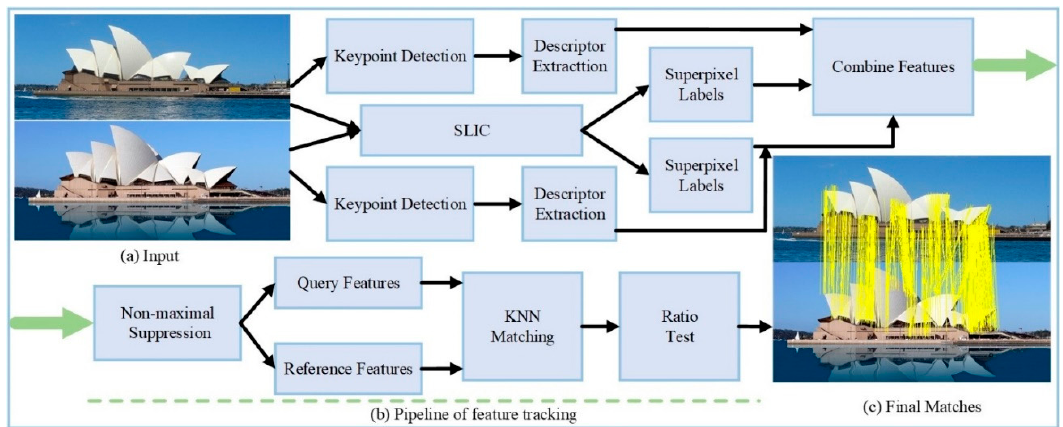
Figure 2. Flowchart of the superpixel-based feature tracking (SPFT) method.